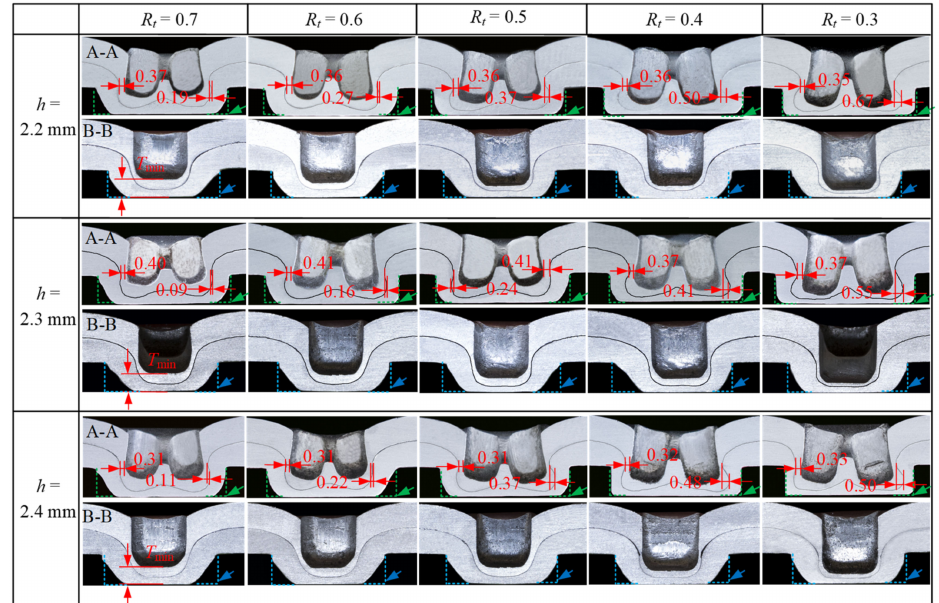
Figure 11. Cross-sectional geometries of joints of sheet thickness t = 2 mm at three die depths h and five values of R t